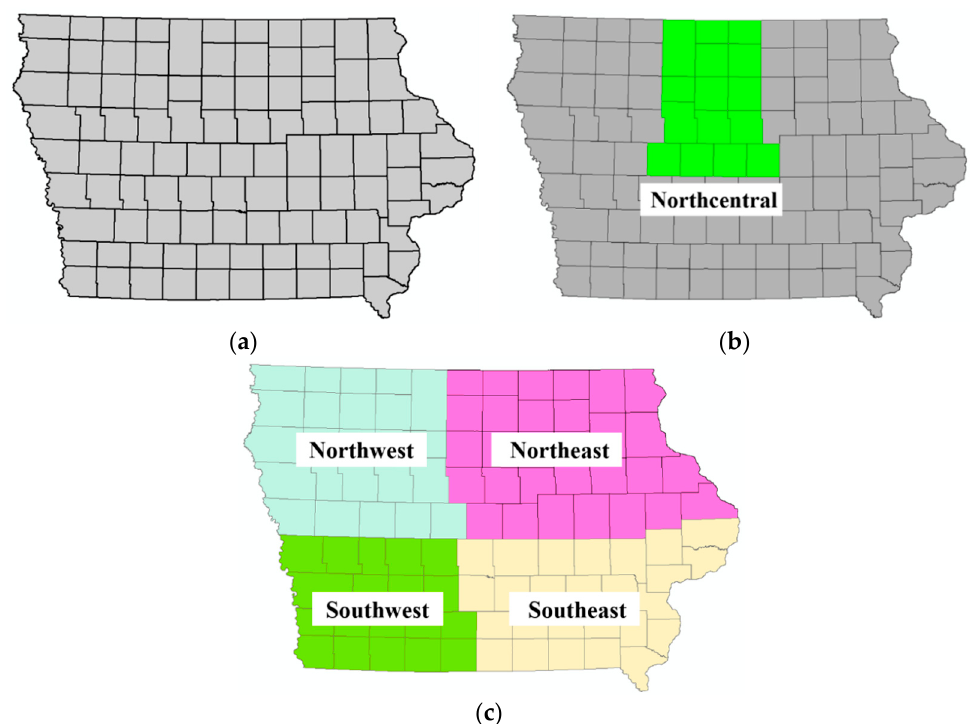
Figure 4. Iowa state study areas ( a ) Whole state, ( b ) Northcentral Zone, and ( c ) Quadrant Zones.